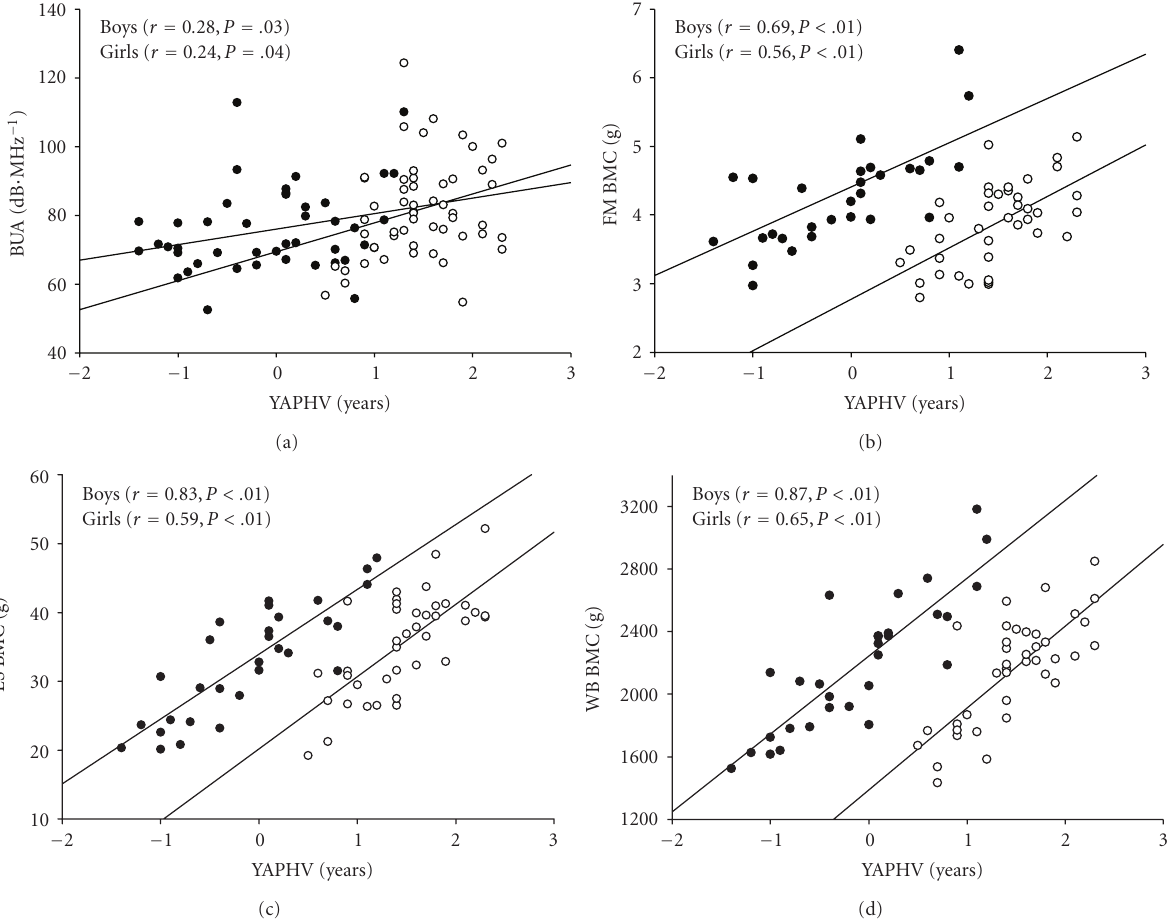
Figure 1: Correlation plots showing relationships between bone parameters and years from peak height velocity (YAPHV) for boys (closed circles) and girls (open circles). (a) BUA, broadband ultrasound attenuation; (b) FN BMC, femoral neck bone mineral content; (c) LS BMC, lumbar spine bone mineral content; and (d) WB BMC, whole-body bone mineral content.